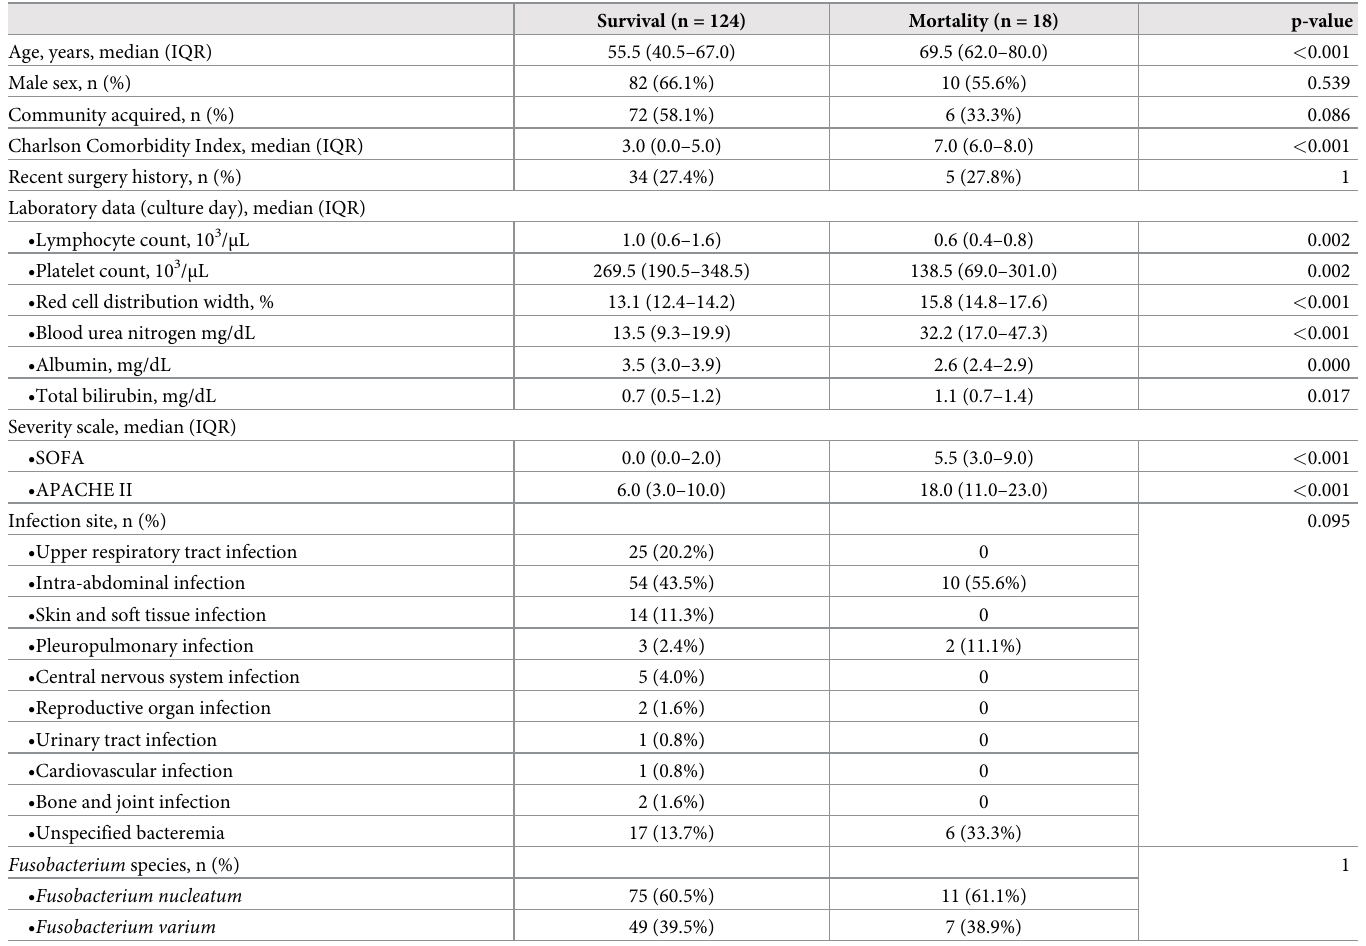
Table 3. Univariate analysis of risk factors for mortality in the F . nucleatum and F . varium groups.